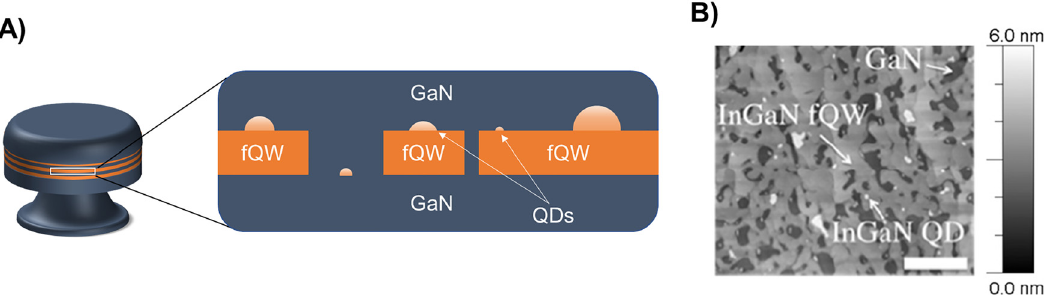
Figure 1: Our microdisk platform. (A) Schematic of a 1- μ m-diameter microdisk laser with three layers of InGaN active material. Inset shows one layer of InGaN fQWs and QDs, showinghowQDsformonthefQWsandunderlyingGaN.(B)Anatomicforcemicroscopy(AFM)imageofactivematerial,specifyingGaN,InGaN fQW, and InGaN QD regions. Taken from the study by Woolf et al. [32]. Scale bar is 500 nm in length, and vertical color scale goes from 0 to 6 nm. QD, quantum dot; fQW, fragmented quantum well; InGaN, indium gallium nitride.